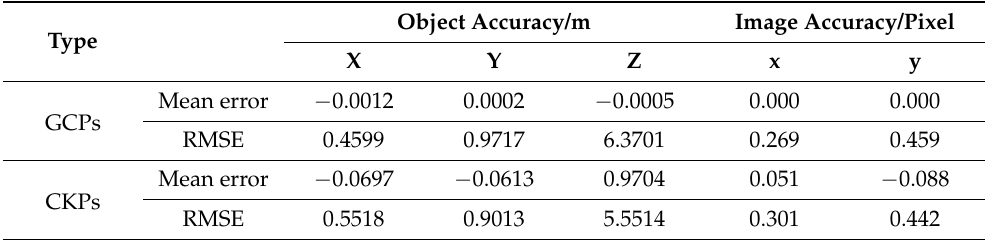
Table 3. The statistical results of the orientation of the stereo images are based on the error- compensated RPCs model.